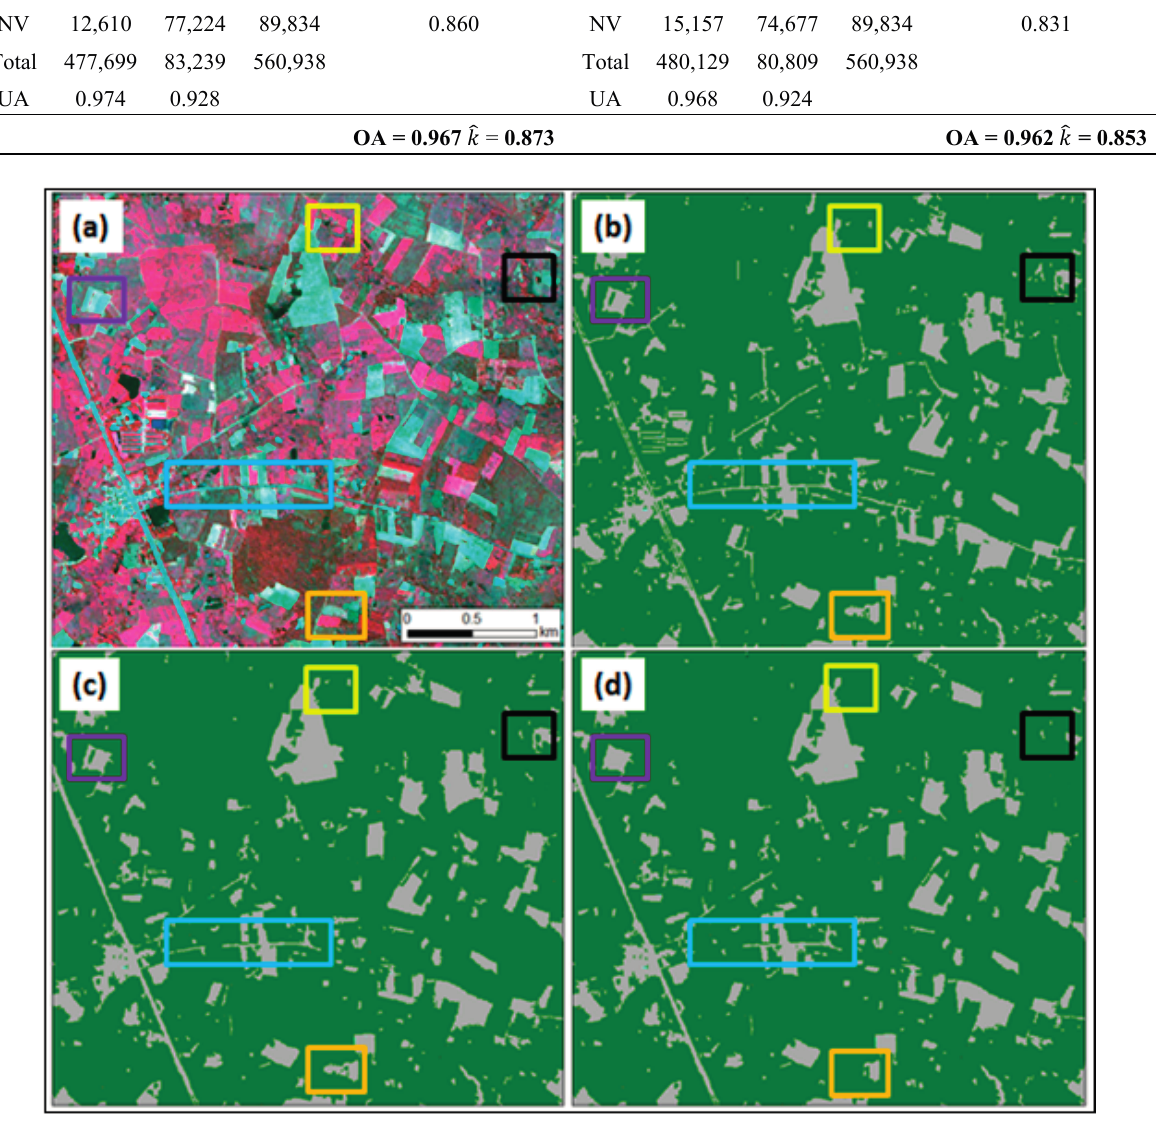
Figure 6. RapidEye image of a mixed agricultural/forested area ( a ) and the baseline object-based classification of this image ( b ). Classification results using SWSF ( c ) and USF ( d ) to extract spectral values (NDVI) from a simulated 30 m resolution image. Green represents “vegetation” and gray represents “non-vegetation” land cover. Colored rectangles highlight some areas with significant differences between the SWSF and USF classification